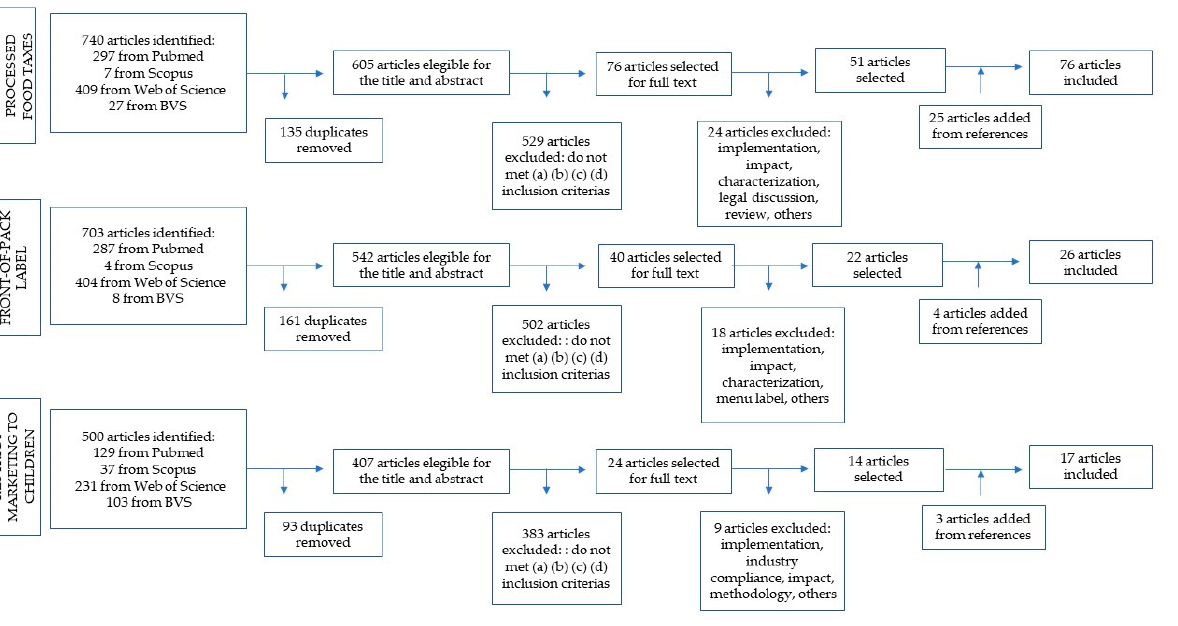
Table 2. Number and percentage of documents characteristics by food